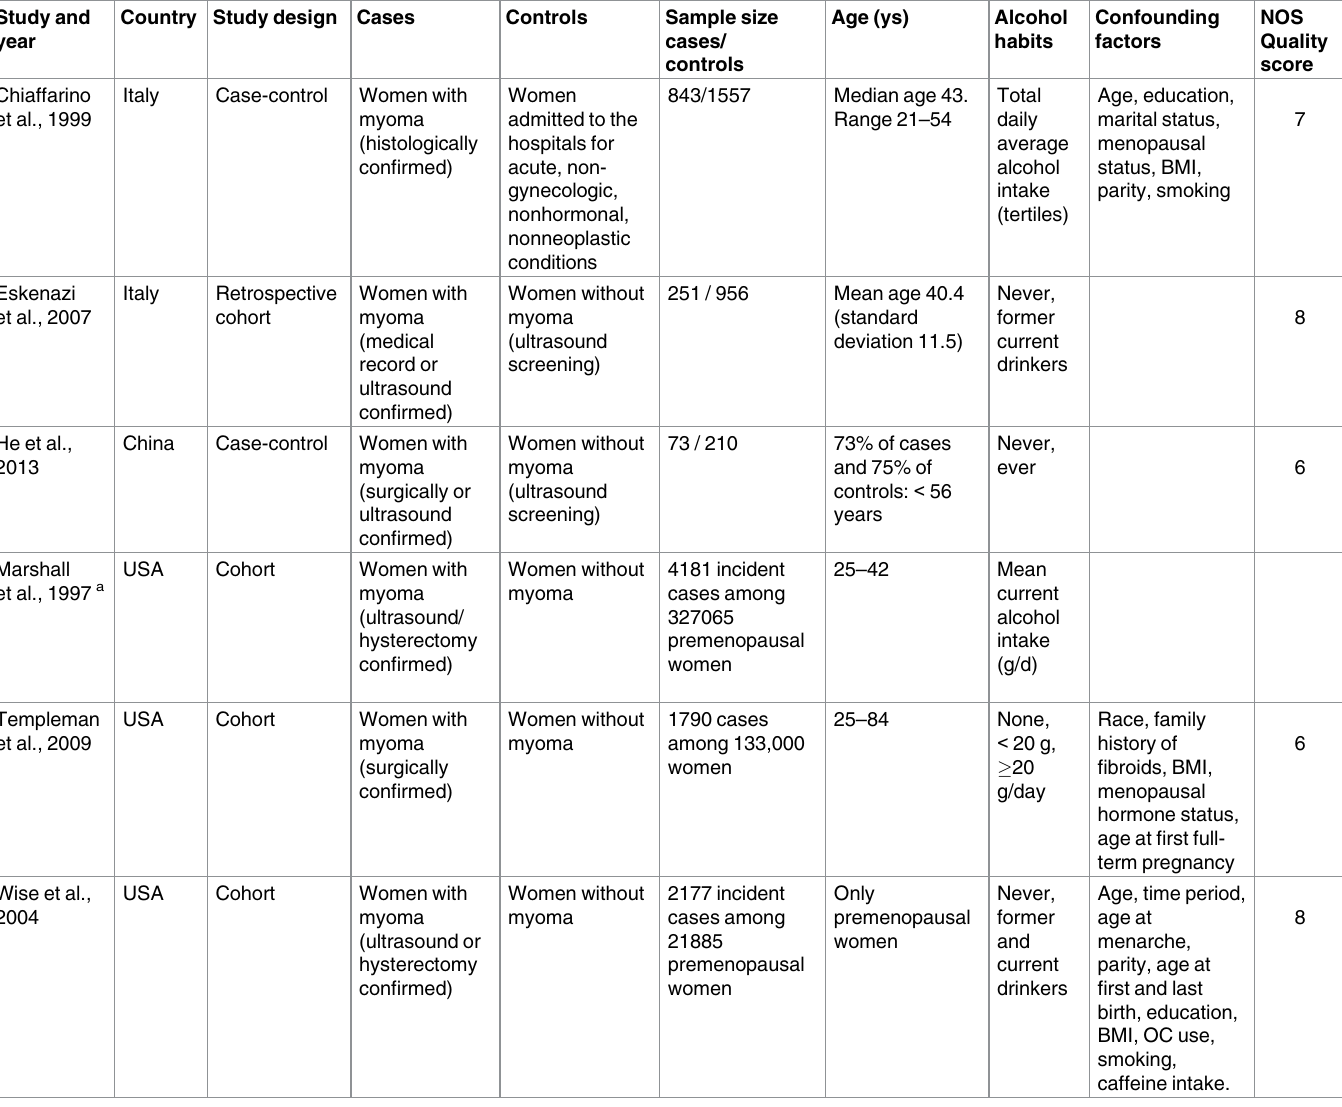
Table 1. Main characteristics of the selectedstudies on alcohol consumption and risk of uterine